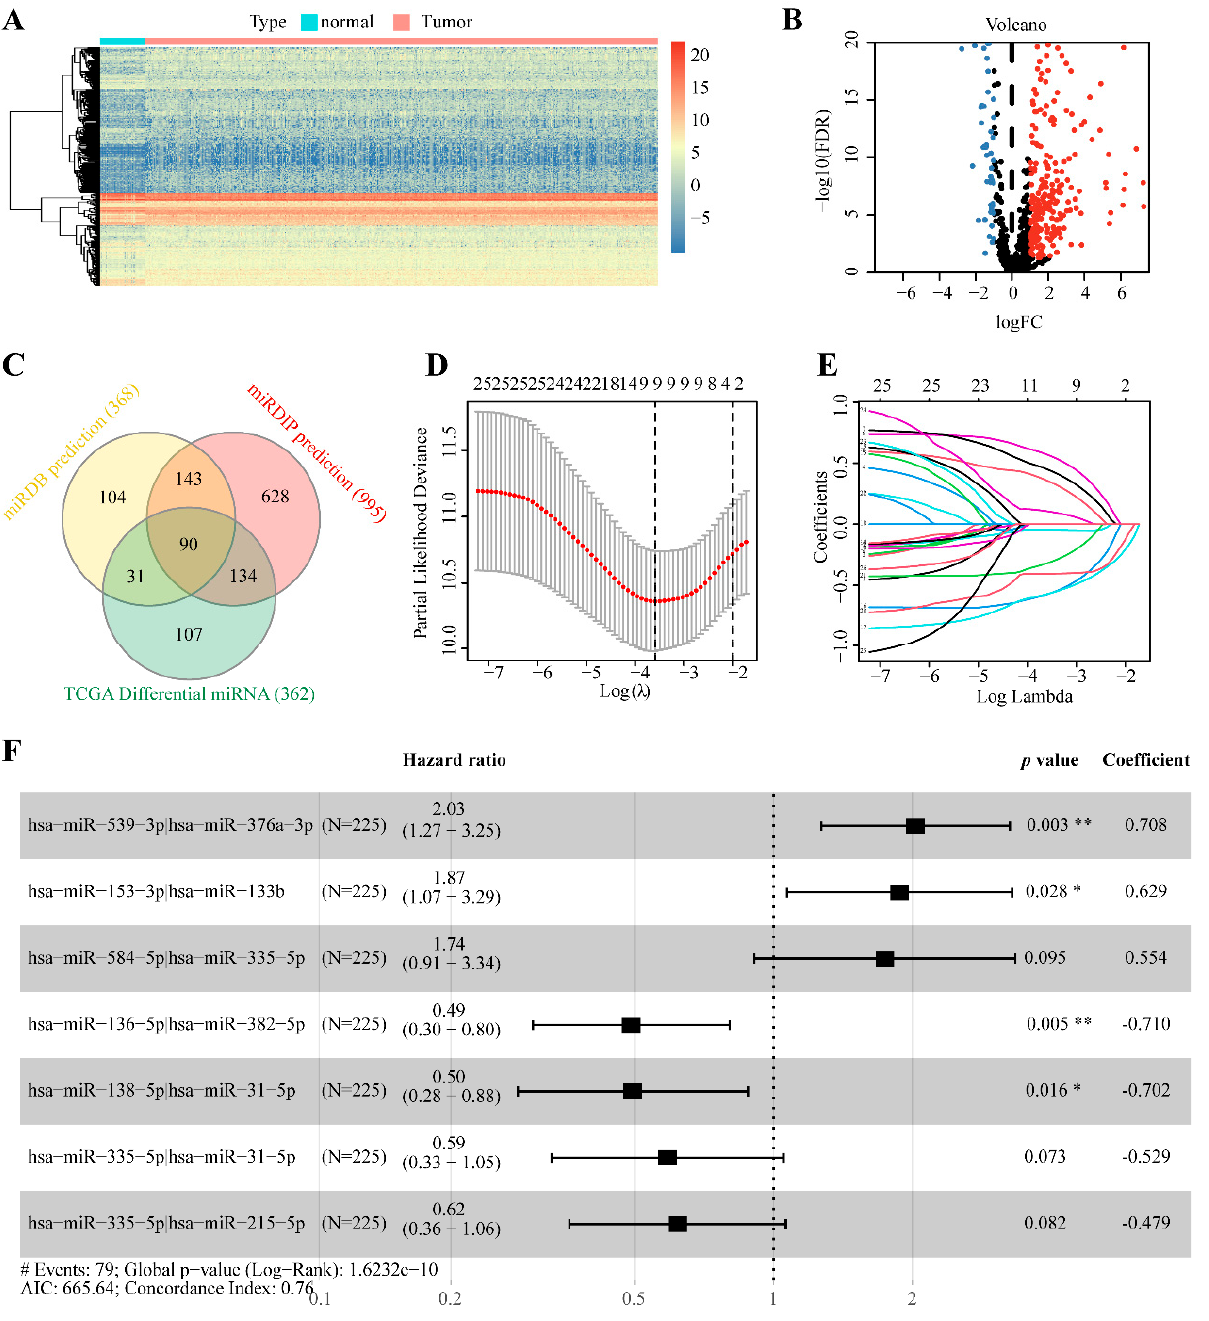
Figure 2. Construction of a prognostic model using cmiRNA Pairs. ( A ) Visualization of miRNA expression and ( B ) differentially expressed miRNA between tumor and normal tissues (red and blue dots indicate up-regulated and down-regulated miRNAs, respectively). ( C ) Venn diagram showing the number of differentially expressed circadian miRNAs (DEcmiRNAs). ( D , E ) Filtration of the DEcmiRNAs pairs using LASSO regression analysis (each differently colored line represents a candidate variable in the LASSO regression analysis). ( F ) The forest map showed the seven cmiRNA pairs of the established prognostic signature. (* p < 0.05; ** p < 0.01).